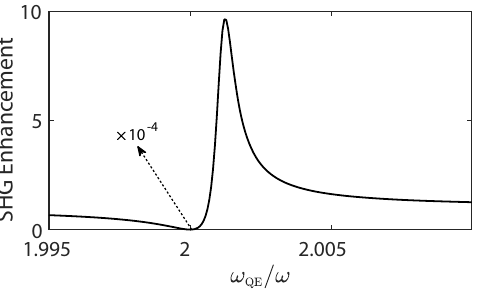
Figure 2: Fano-enhancement of the SHG, which multiplies the localization enhancement [41], for different 𝜔 tuned between × 10 − 4 and × 10 by adjusting the QE level-spacing 𝜔 an applied